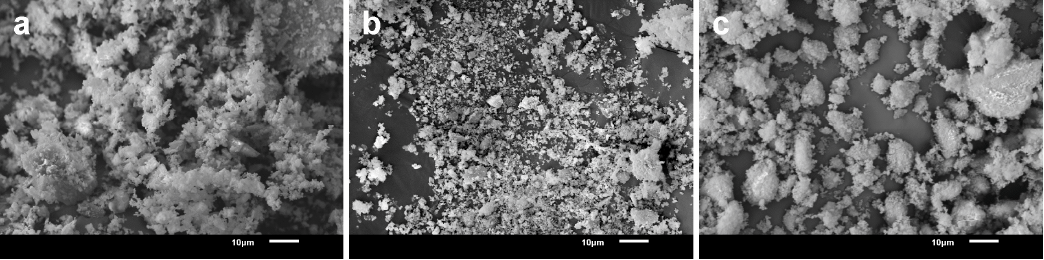
Figure 5. SEM images of the studied pyroxenite: ( a ) ball-milled for 1 h (BM8); ( b ) ball-milled for 4 h (BM10); ( c ) ball-milled for 32 h (BM33).